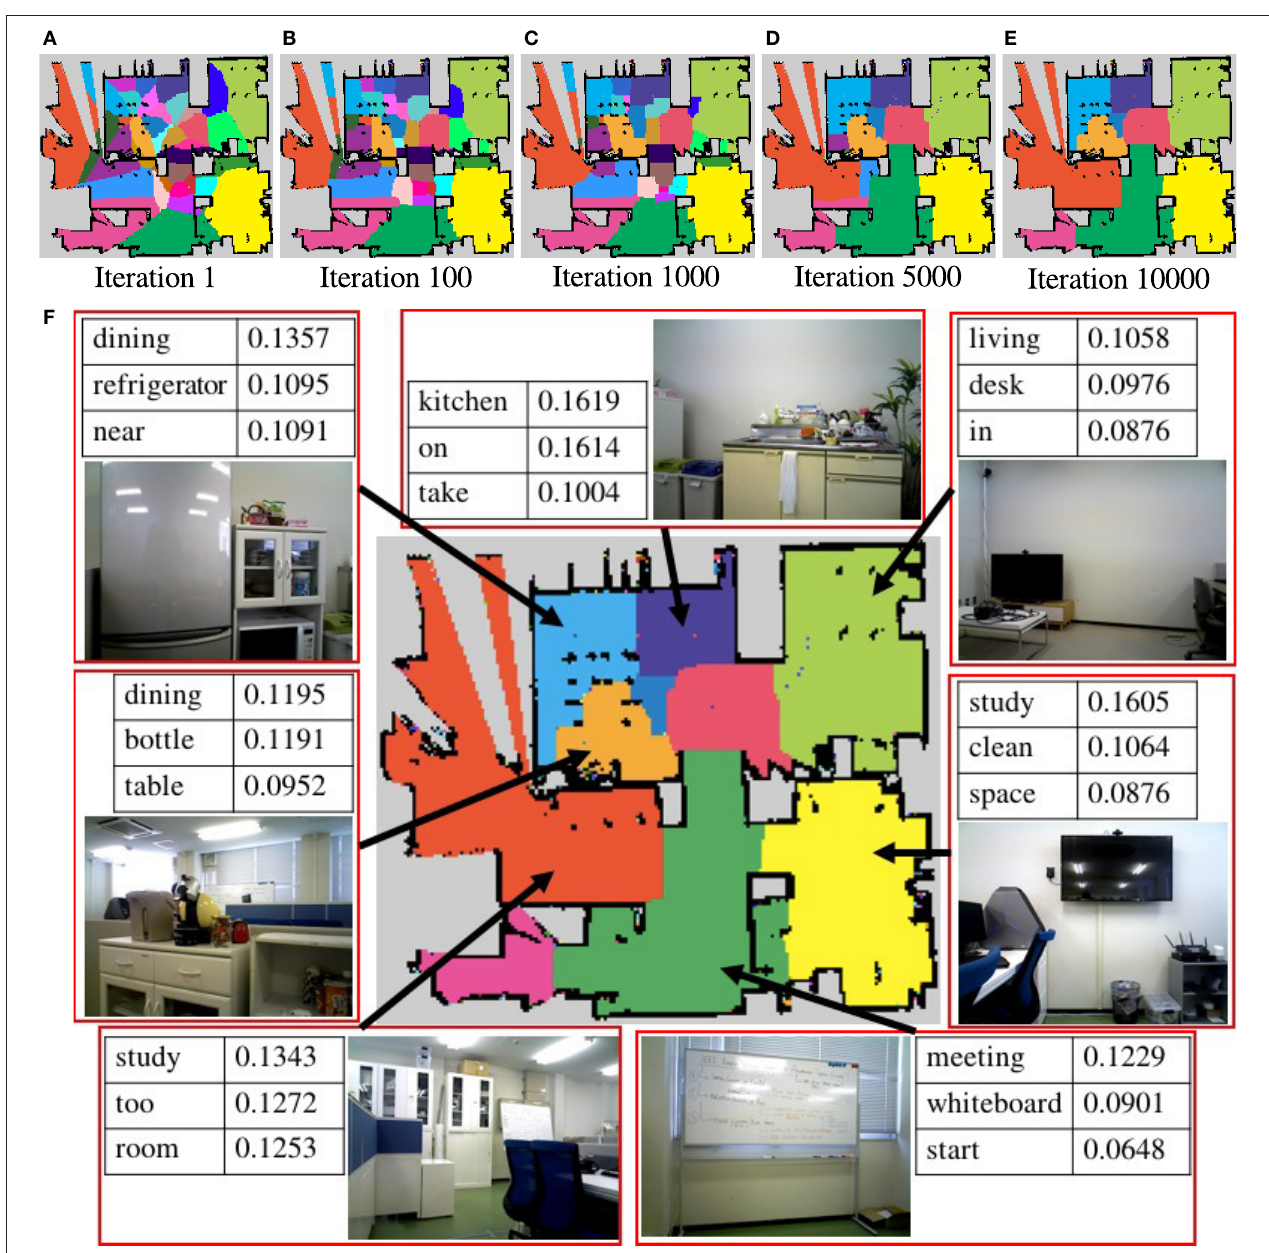
FIGURE 10 | (A–E) The semantic maps generated by SpCoMapping in each iteration. Each color represents a different spatial concept. (F) The semantic map of the final iteration, with the three best words obtained for the representative spatial concept and some examples of image given at that place. The number in the tables represents the word probability of the spatial